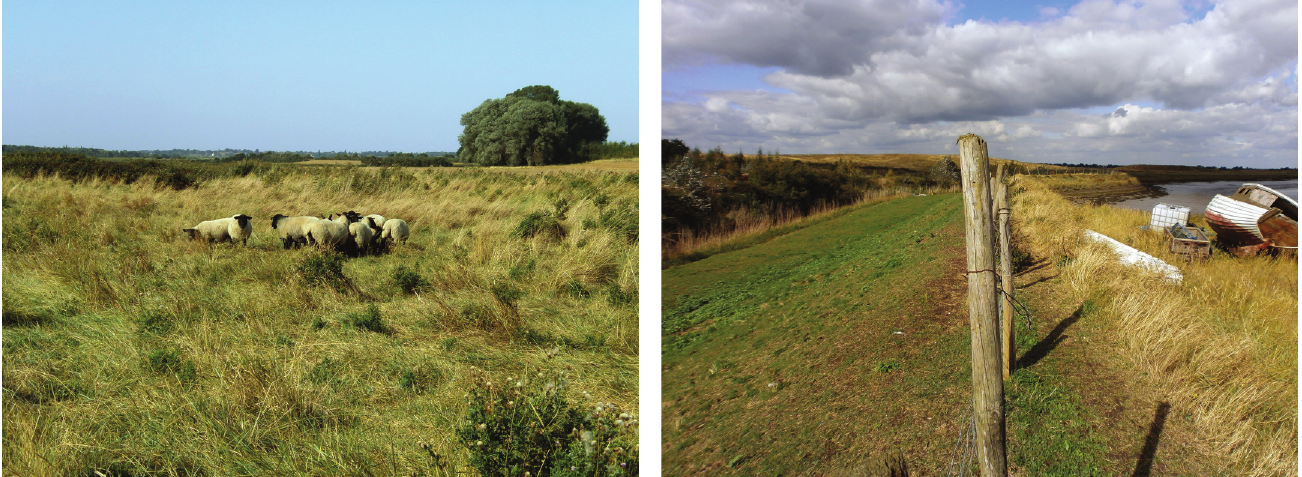
Fig. 4. Sheep grazing on a sea wall folding creating a heterogene- ous, patchy sward favorable for Orthoptera (Brightlingsea, Essex, UK); credit T. Gardiner.